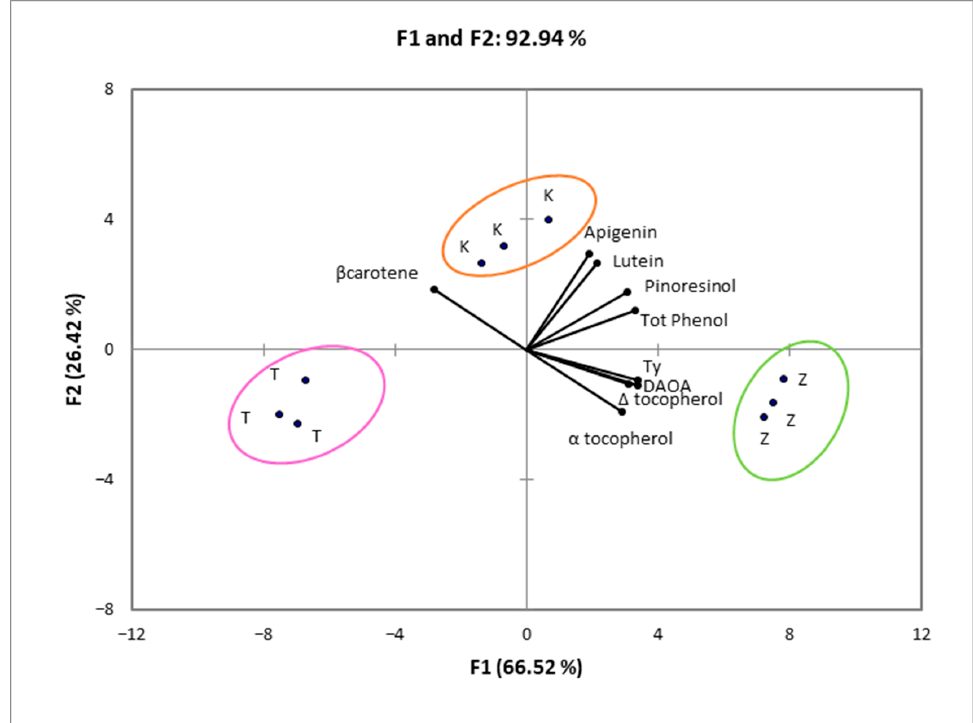
Figure 2. PCA analysis of chemical parameters determined in oils produced by plants sprayed with different particle film. K = kaolin, Z = zeolitite, T = untreated control.